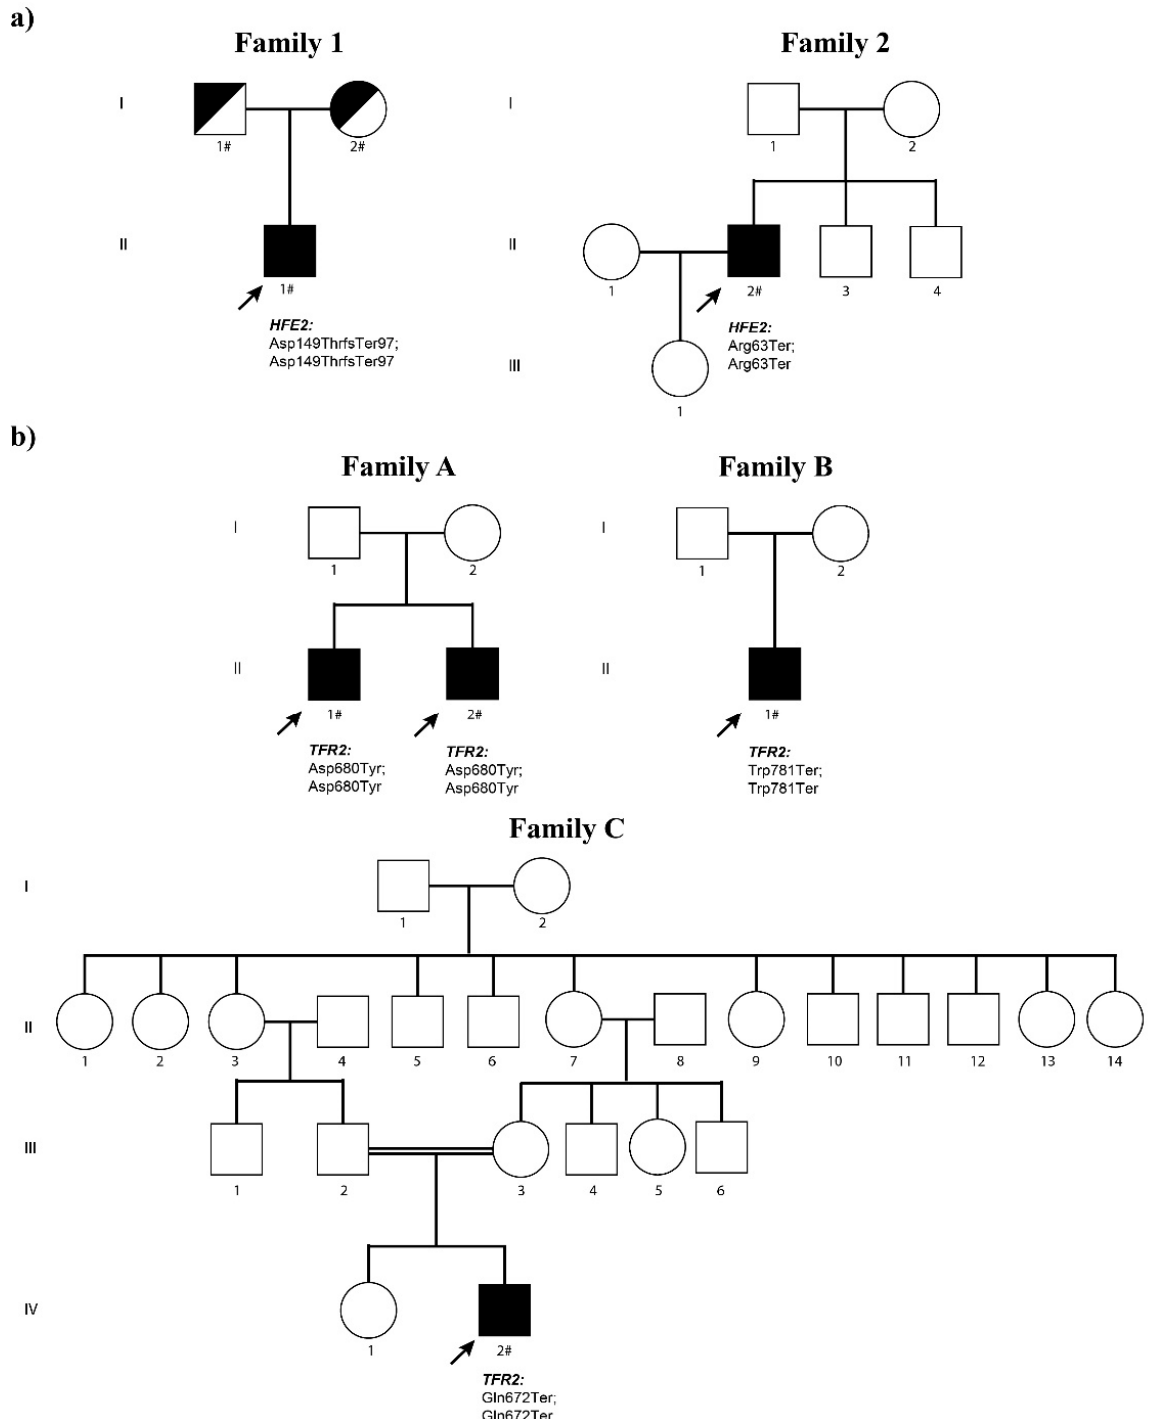
Figure 4. Non-HFE hereditary hemochromatosis families: families and mutations. The probands are indicated with an arrow. Black symbols denote affected individuals and half-filled black symbols unaffected carriers. Individuals studied at the molecular level are indicated with the # symbol. ( a ) Pedigrees of the two non-HFE related HH families carrying HFE2 mutations. ( b ) Pedigrees of the three non-HFE related HH families carrying TFR2 mutations. 2.1.3. Non-HFE HH Related due to Mutations in the TFR2 Gene: Family A Patients A.II.1 and A.II.2 (Figure 4b upper first panel) are two male brothers of Asian origin diagnosed with HH at 35 and 37 years old respectively. Both presented with high levels of serum ferritin and iron, while in both patients, the hepcidin levels were 0.2395